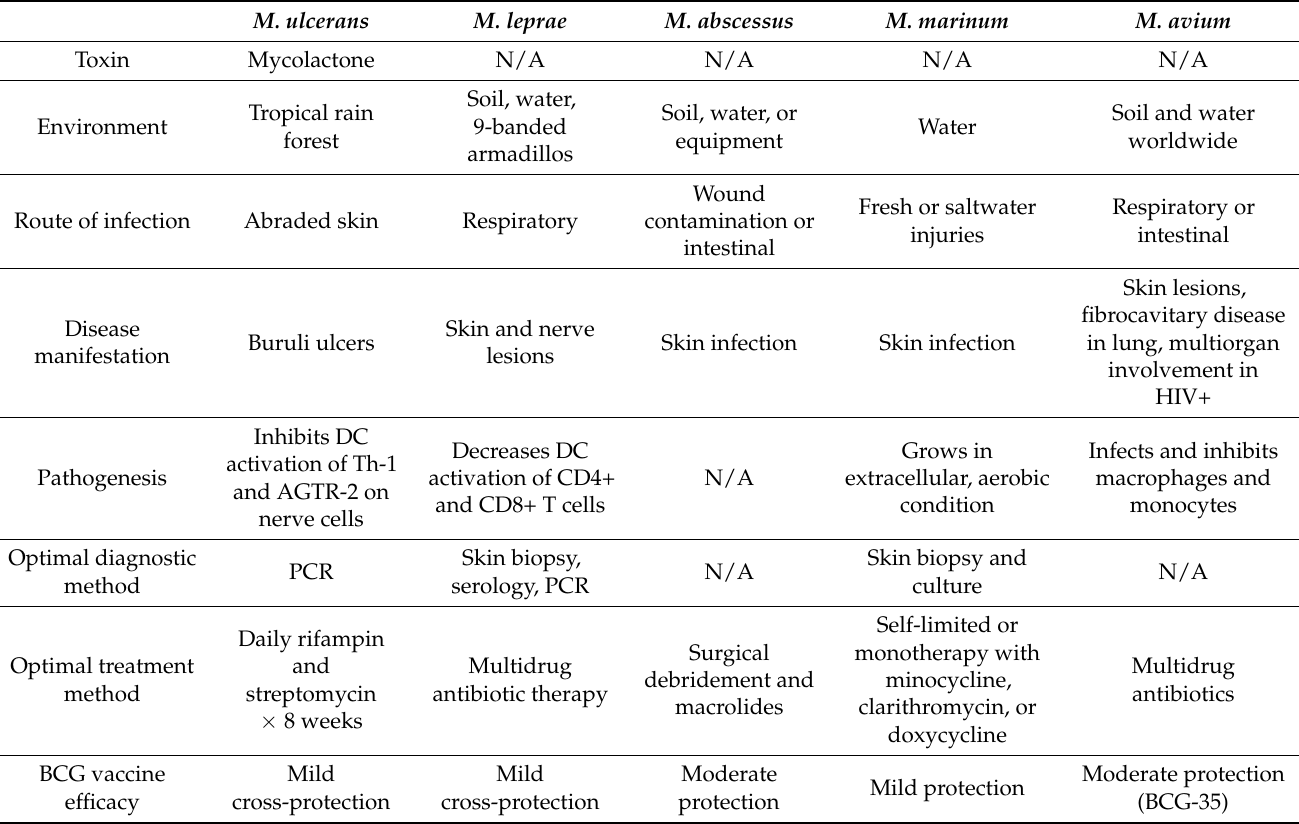
Figure 2. Administration of BCG and/or recombination forms of BCG result in an increase in TNF- alpha, IFN-gamma, and T cell proliferation, as well as other pro-inflammatory cytokines, leading to a more robust immune response against NTM infection. Table 2. Summary of the various NTMs and their key characteristics regarding pathogenesis, diagno- sis, treatment, and BCG vaccine